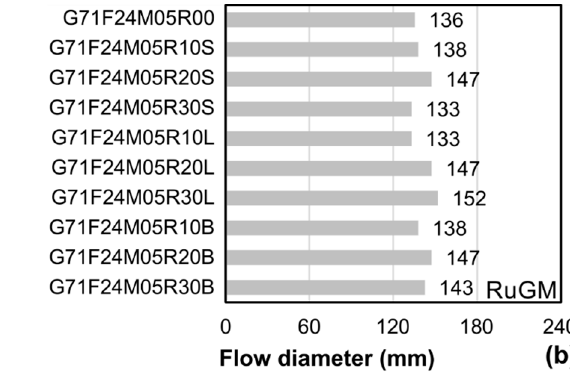
Figure 4. Flow diameter for: ( a ) CGM, ( b ) RuGM.